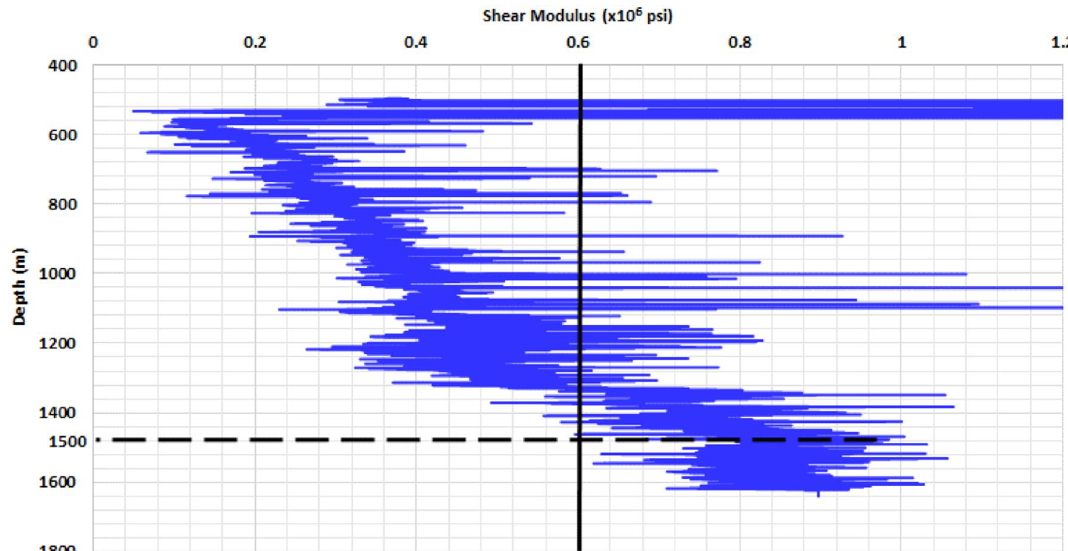
Fig. 8 Shear modulus with